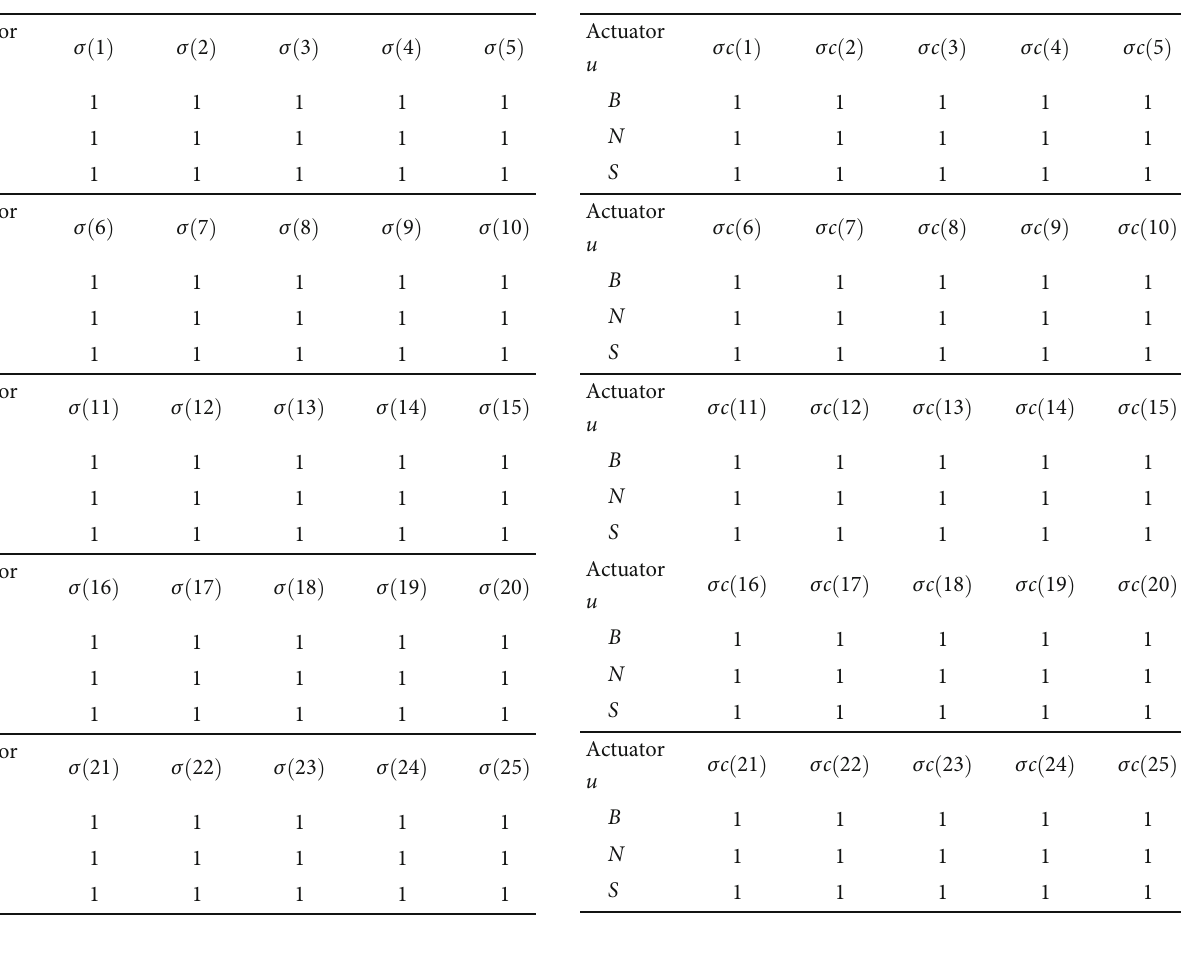
Table 7: Initial values of clustering width σ . Table 8: Initial values of the error change rate σ c